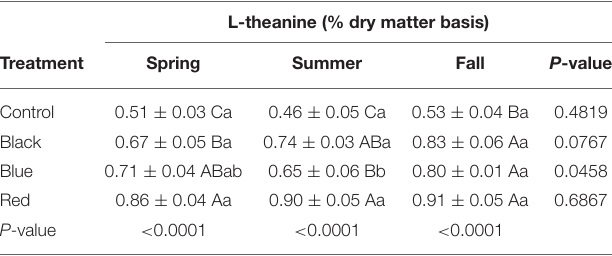
Means followed by different uppercase letters within each column suggest significant difference between shade treatments and different lowercase letters within each row suggest significant difference between harvesting seasons according to Tukey’s HSD test at p <